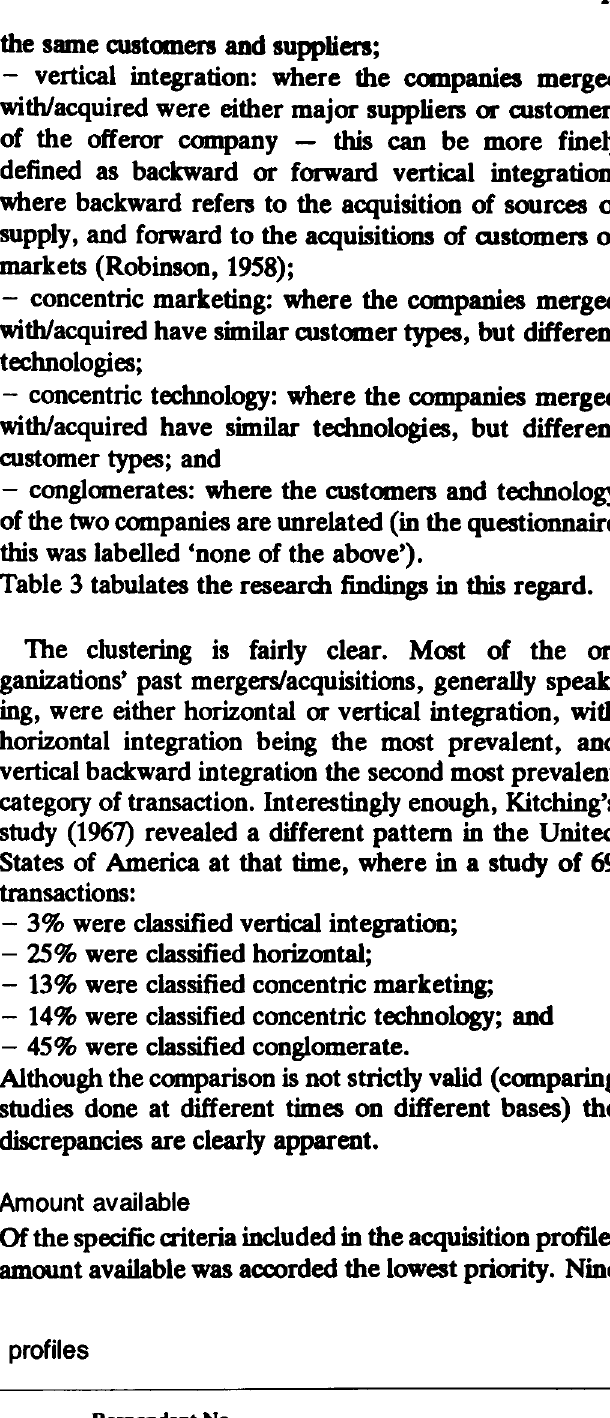
Table 2 Nature of business/industry specified in acquisition profiles Nature of profile Same as present nature